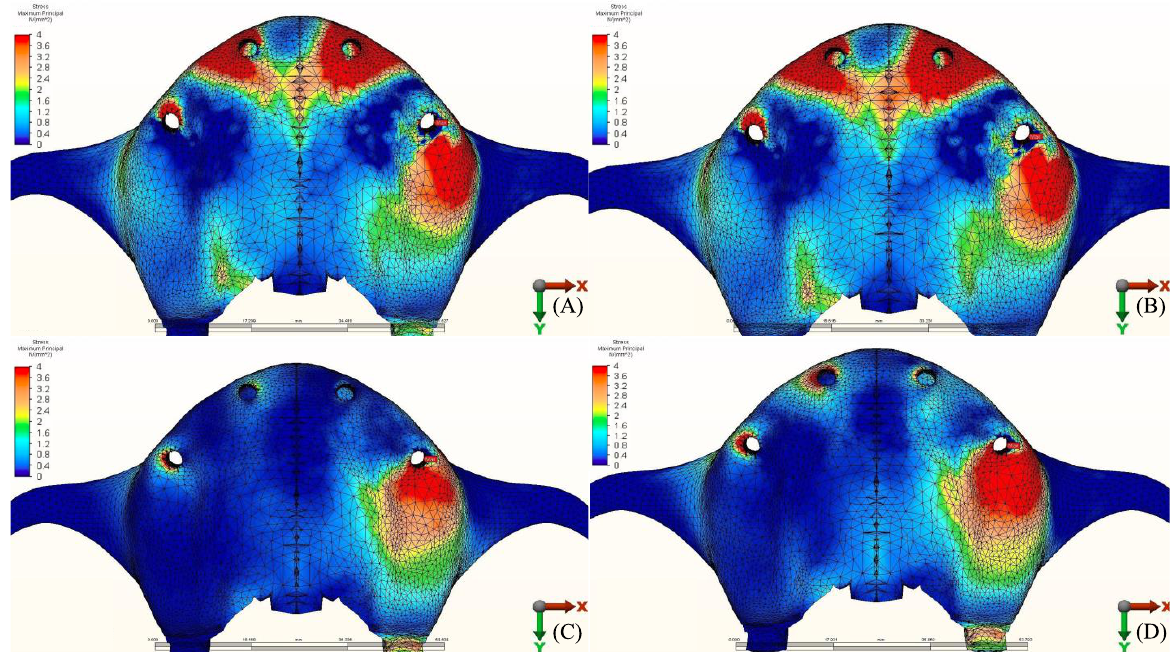
Figure 6. Pmax stress distribution in cortical bone for group 2, titanium bar with resin composite gingiva and ceramic superstructure with zirconium (Toronto bridge). ( A ) Model 2.1, opposing natural tooth. ( B ) Model 2.2, opposing tooth-supported full ceramic crown. ( C ) Model 2.3, opposing acrylic prosthesis with titanium framework. ( D ) Model 2.4, opposing implant-supported full ceramic crown.